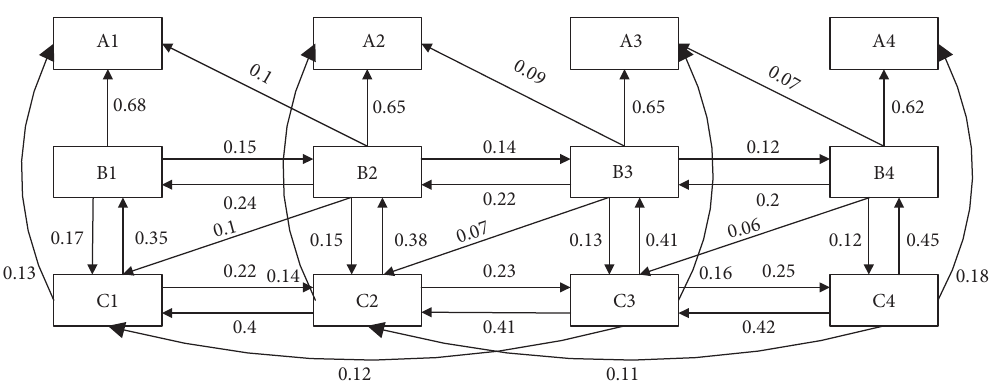
Figure 11: The diagram of spatial units in the transition area.